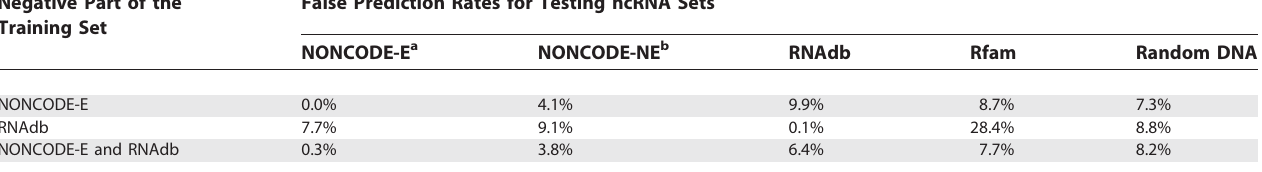
Table 2. ncRNA False Prediction Rates for Different Datasets Negative Part of the Training